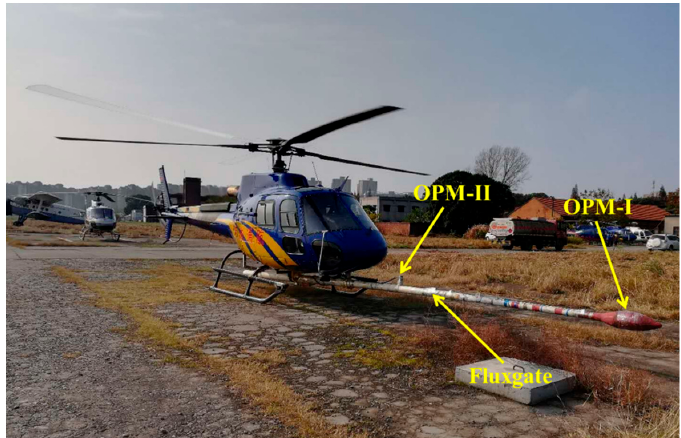
Figure 1. The helicopter platform and equipment.